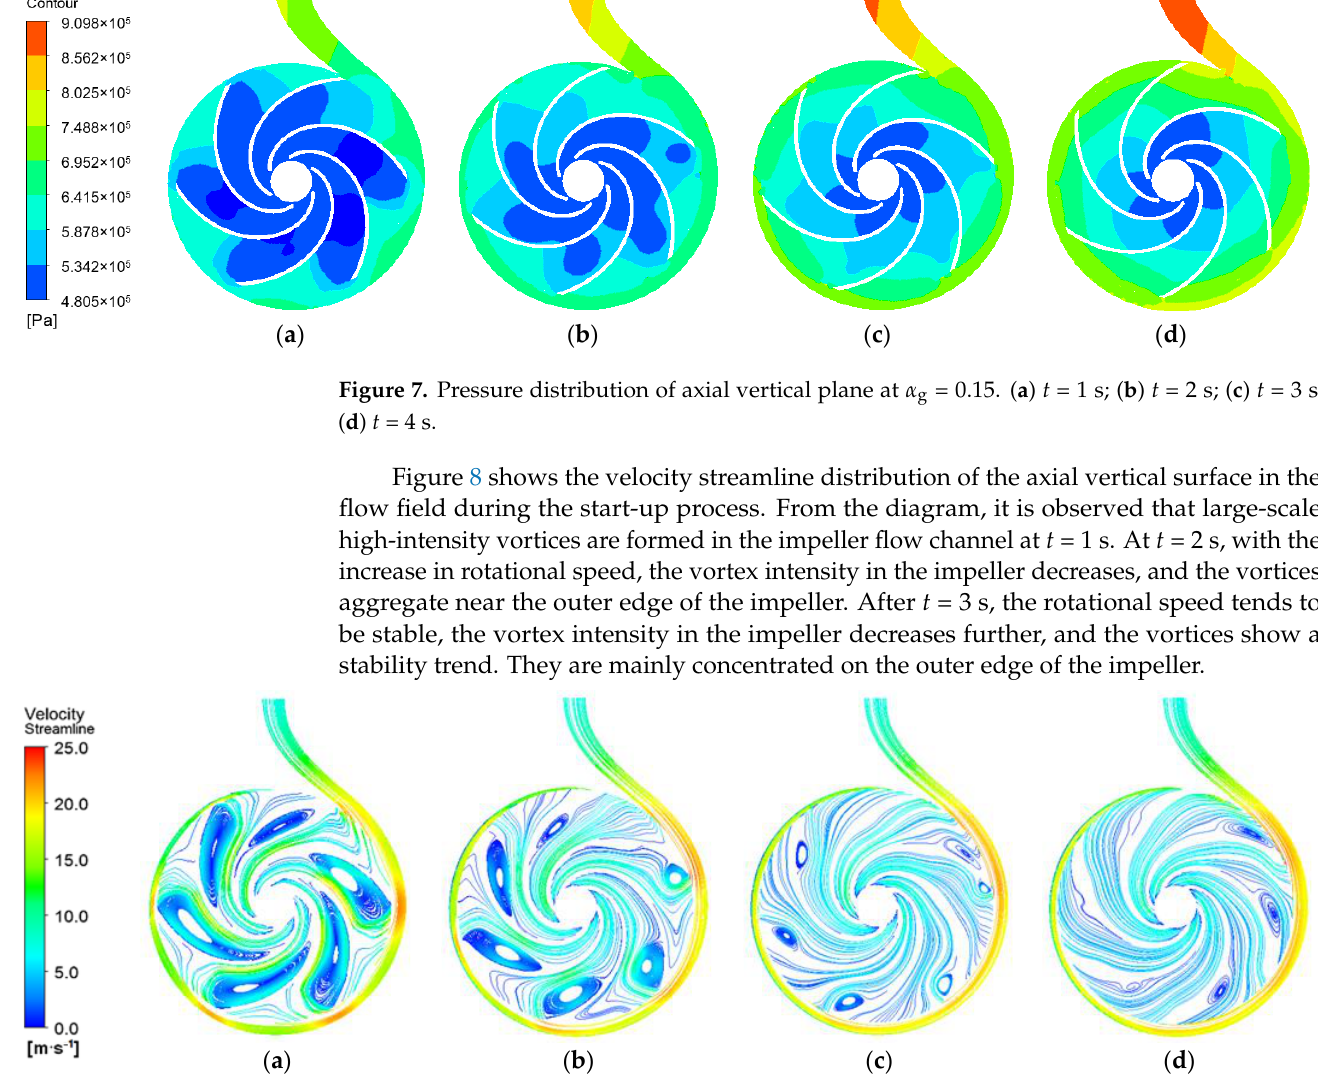
( d ) Figure 9. Gas volume fraction distribution of axial vertical plane at α g = 0.15. ( a ) t = 1 s; ( b ) t = 2 s; ( c ) t = 3 s; ( d ) t = 4 s.